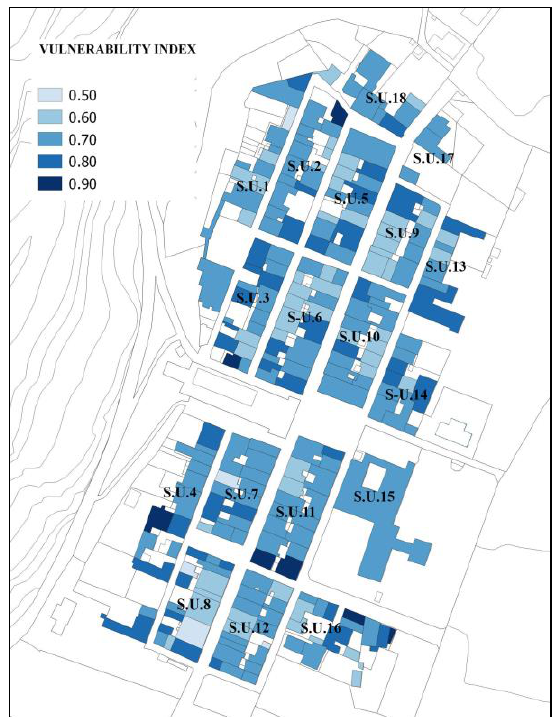
Figure 3. Macroseismic Vulnerability Index of a part of the city of Scarperia. The results are extracted from the GIS platform.